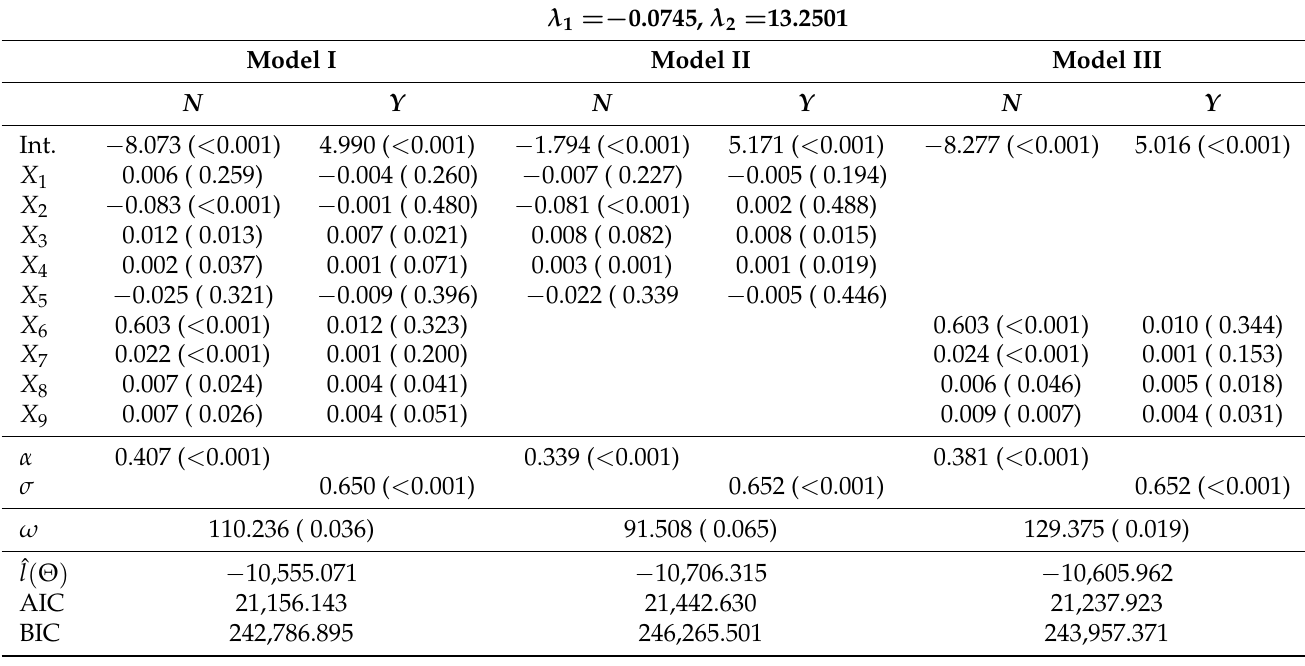
Table 3. Parameter estimates ( p -values) and goodness of fit statistics for the bivariate Sarmanov models with GLM marginals for number ( N ) and mean cost ( Y ) per